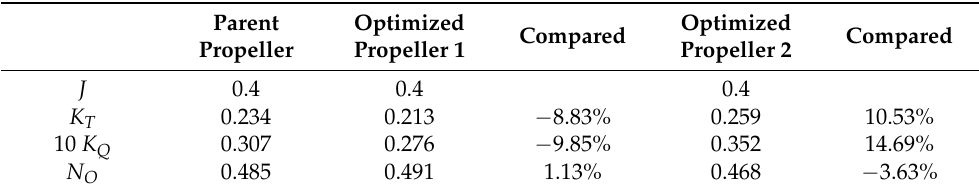
Table 8. J = 0.4 performance comparison of open water.